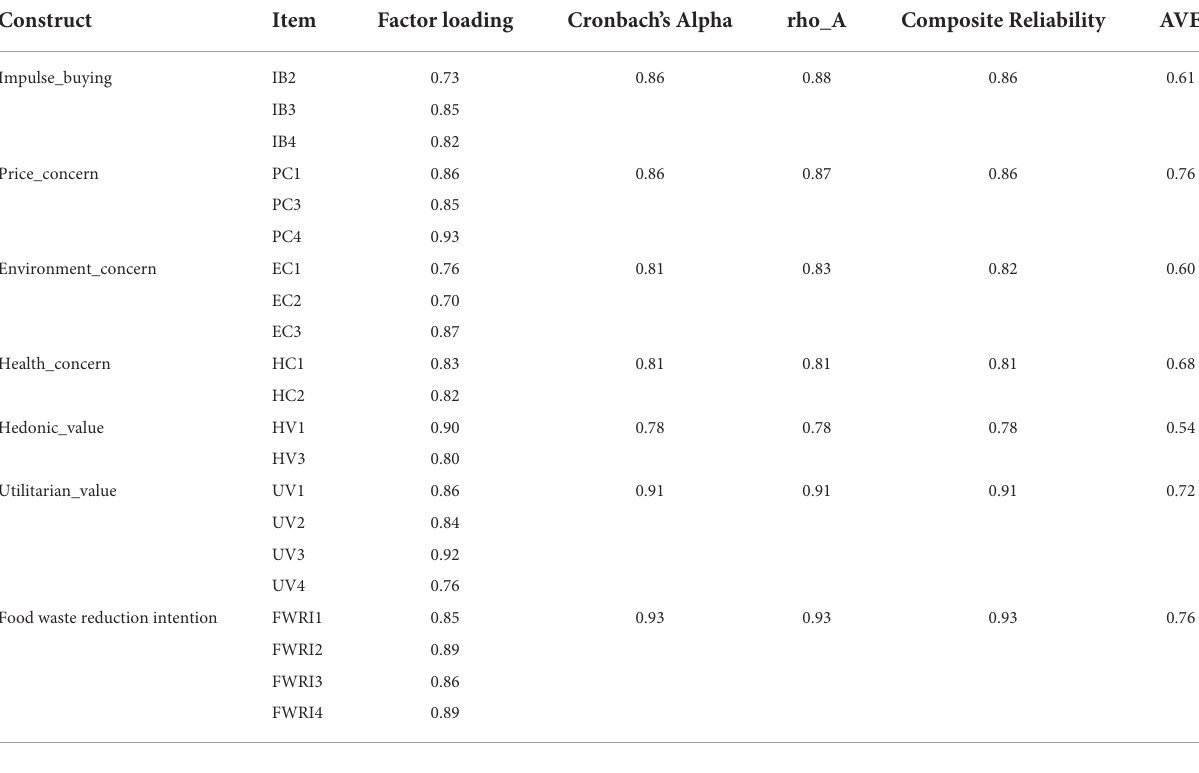
TABLE 2 Result of convergent validity.